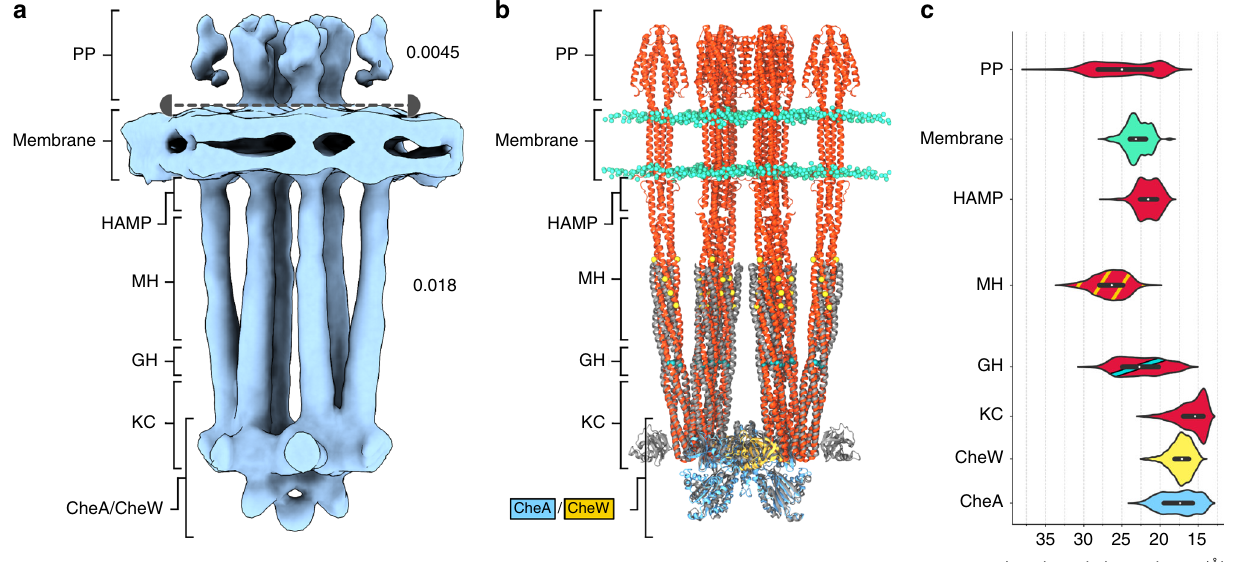
Fig. 4 Cryo-ET map of the CSU interpreted in the light of the resulting molecular model. a Subtomogram average of the CSU. The map is shown as an isosurface representation above and below the capped, dashed line at thresholds of 0.0045 and 0.018, respectively. Regions corresponding to the periplasmic ligand-binding domains (PP), the membrane, the HAMP domains, methylation-helix bundles (MH), fl exible regions containing the glycine hinge (GH) and kinase control (KC) modules of the receptors are labelled, as well as the CheA/CheW baseplate. b Molecular model of the CSU. Receptors are depicted in red, CheA in blue, and CheW in gold. Membrane headgroups, methylation sites, and glycine hinge residues are shown as cyan, yellow, and teal spheres, respectively. The region of a previously published T. maritima CSU model (PDB 3JA6), modelled from a subtomogram average of E. coli chemoreceptor arrays, is superposed in grey. c Distribution of local resolution estimates in different regions of the CSU. Source data are provided as a Source Data fi